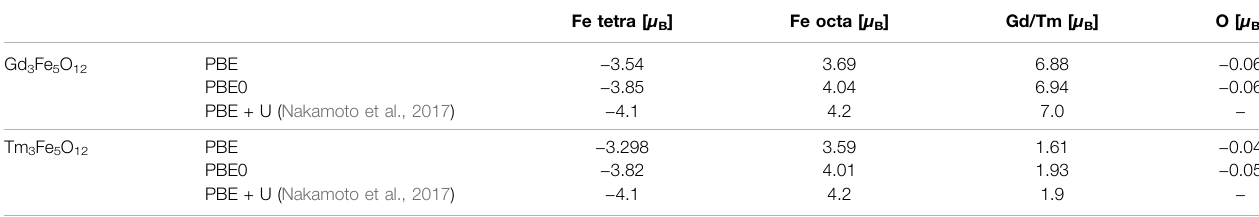
TABLE 2 | Predicted magnetic moments of GdIG and TmIG for each atom type, given in units of [ μ B